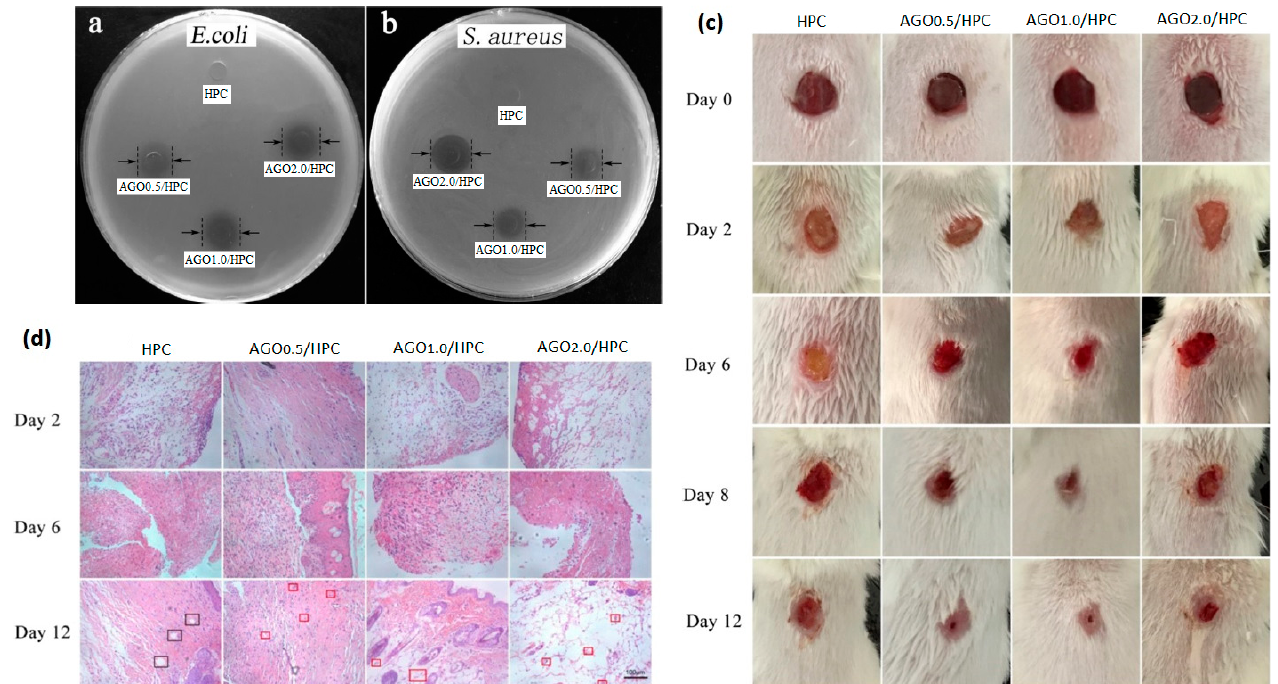
Figure 7. Inhibition zone on plates with solid-state nutrient agar against ( a ) E. coli and ( b ) S. aureus showing the corresponding diameters of the inhibition zone induced by HPC, AGO 0.5 /HPC, AGO 1.0 /HPC and AGO 2.0 /HPC; ( c ) in vivo BALB/C mouse wound healing model with a 6 mm-diameter of wound on the back, infected with S. aureus (1.0·10 7 CFU/mL) and treated with HPC, AGO 0.5 /HPC, AGO 1.0 /HPC and AGO 2.0 /HPC for 0, 2, 6, 8 and 12 days; ( d ) haematoxylin and eosin staining of histological section of skin wound in mice treated with HPC, AGO 0.5 /HPC, AGO 1.0 /HPC and AGO 2.0 /HPC for 2, 6 and 12 days post-wound induction (scale bar = 100 µm). Adapted from [132]. Copyright © 2019 American Chemical Society.